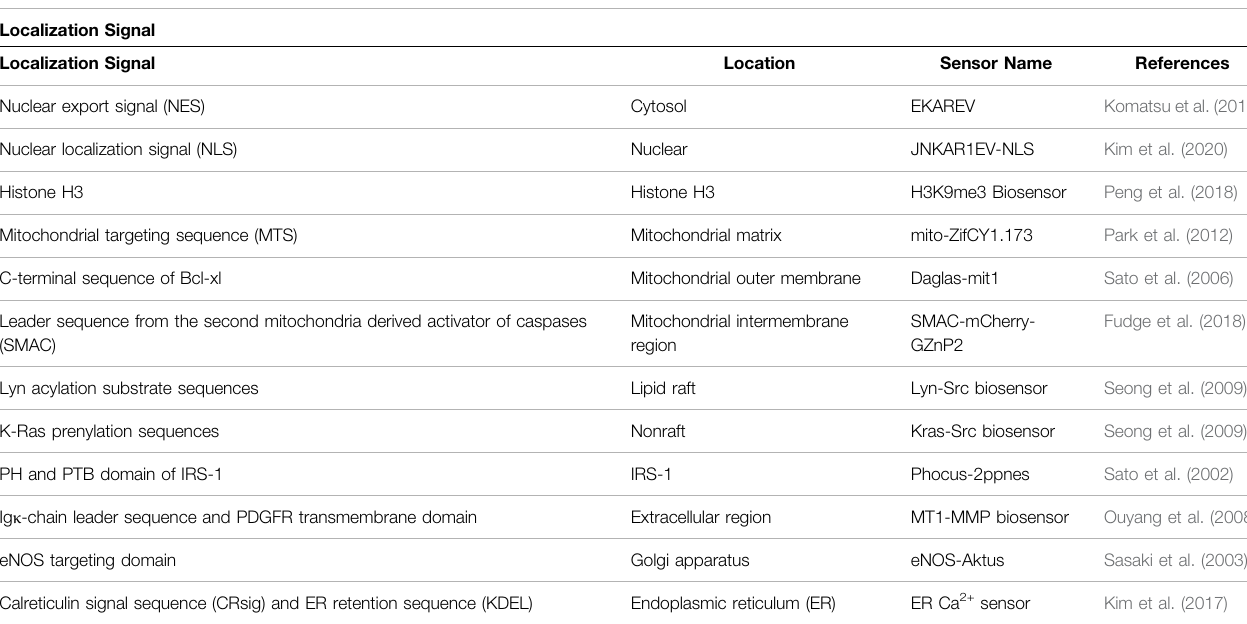
TABLE 4 | Summary of representative localization